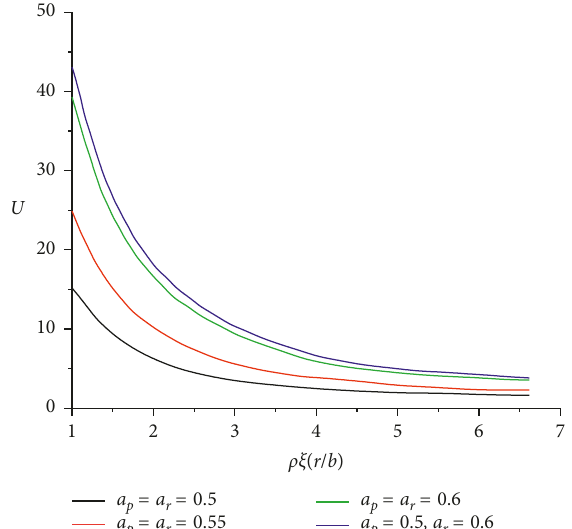
based on the M-C rock mass. ∗